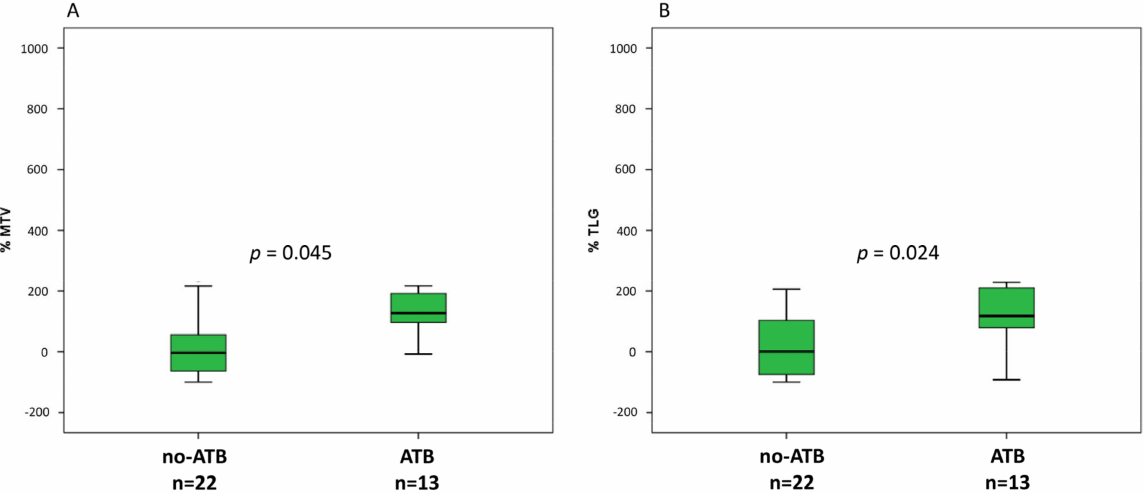
Figure 4. Box plots for number of percentage of variation of MTV ( A ) and TLG ( B ) at first assessment after approximately 6–7 weeks from ICI started. Table 2. Patient characteristics and association between ATB and metabolic variables at baseline and at first re-evaluation. Variable All Patients ( n = 50) ATB ( n =